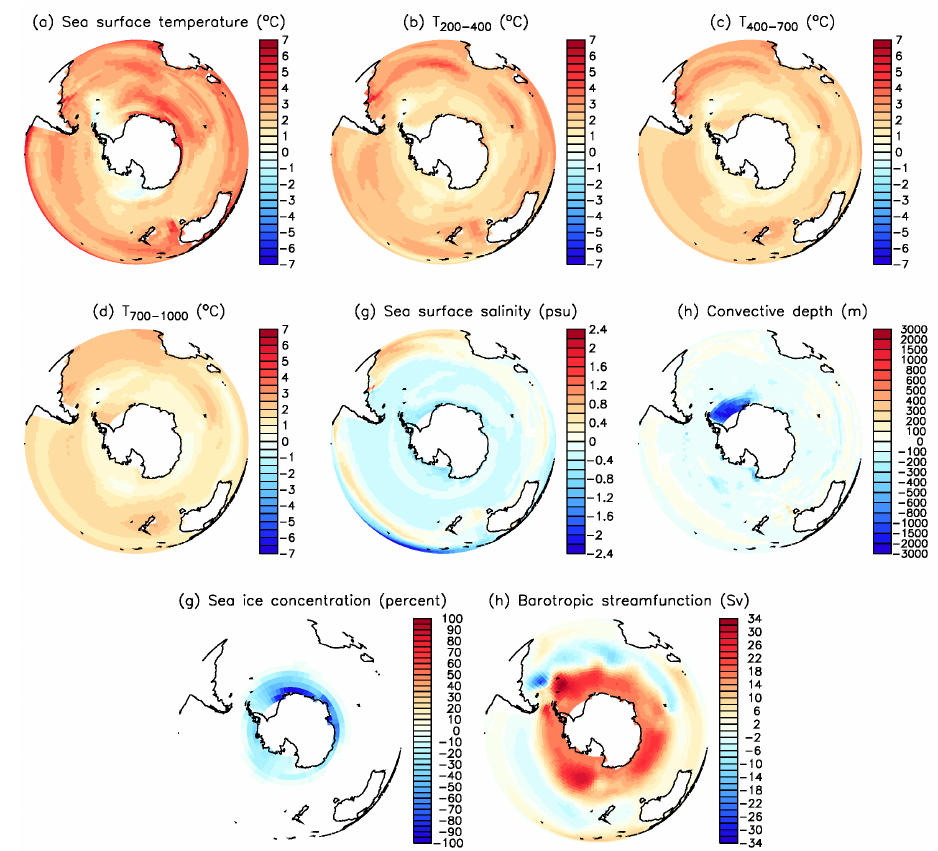
Figure 9. As Fig. 5, but for the first 100 years after the atmospheric CO 2 concentration has stabilised (i.e. years 141–240) in experiment